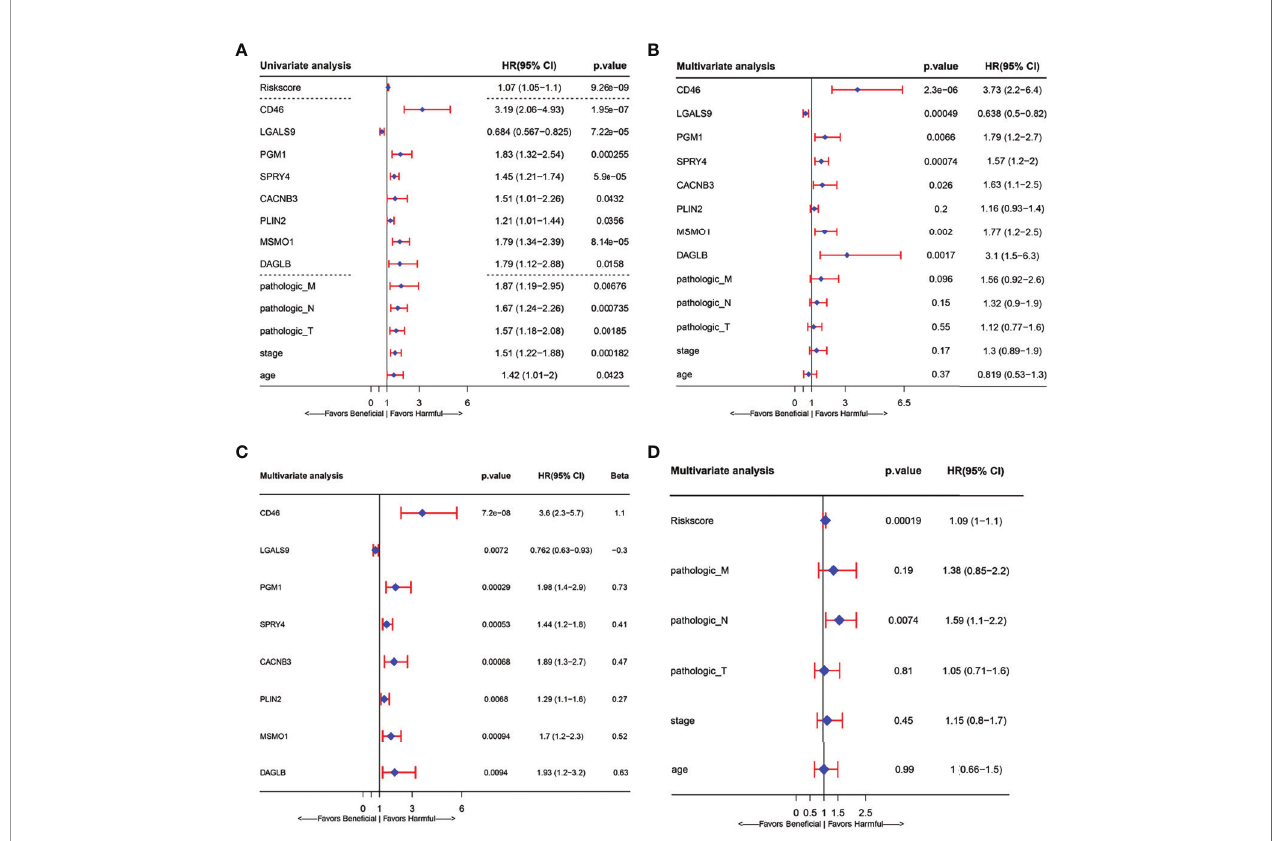
FIGURE 5 | Forest plots presenting the univariate and multivariate Cox regression analysis of prognostic HLA-G-driven DEGs in model for overall survival (OS). (A) Forest plot for the univariate Cox analysis of risk score, risk signature related genes(CD46, LGALS9, PGM1, SPRY4, CACNB3, PLIN2, MSMO1, and